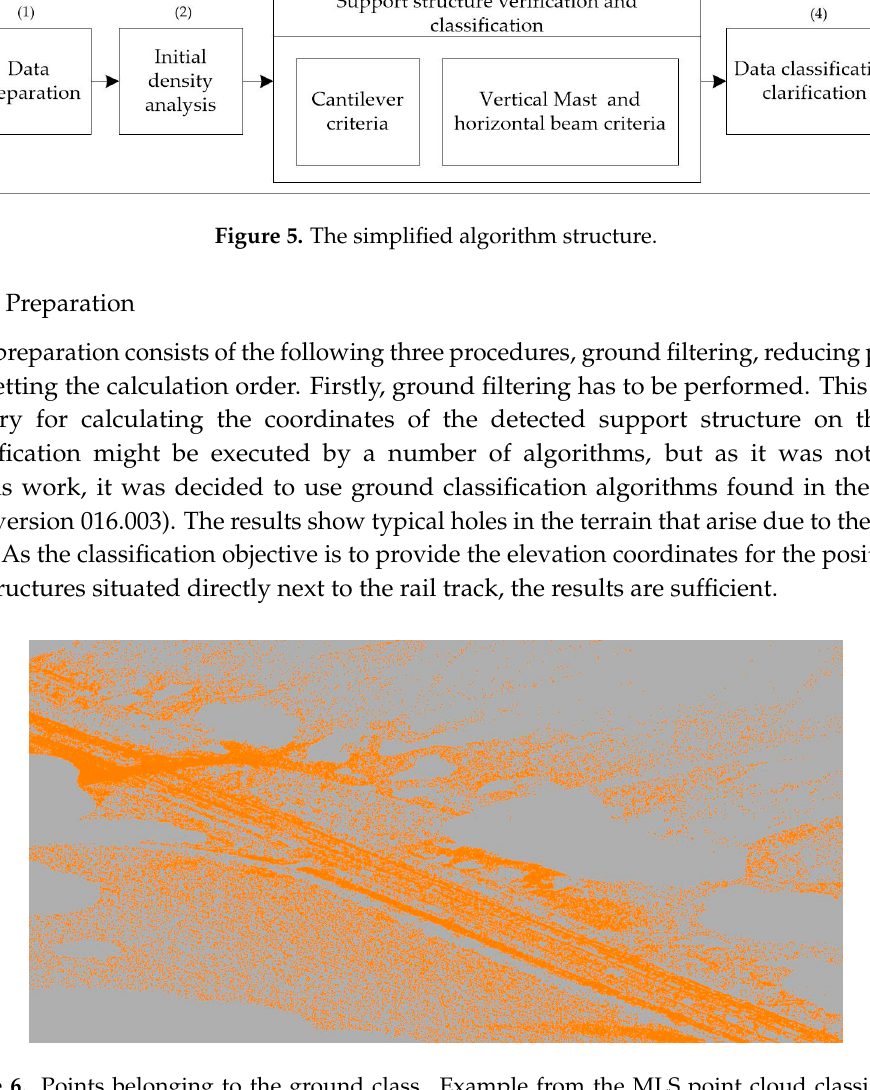
Figure 6. Points belonging to the ground class. Example from the MLS point cloud classified in TerraScan software.